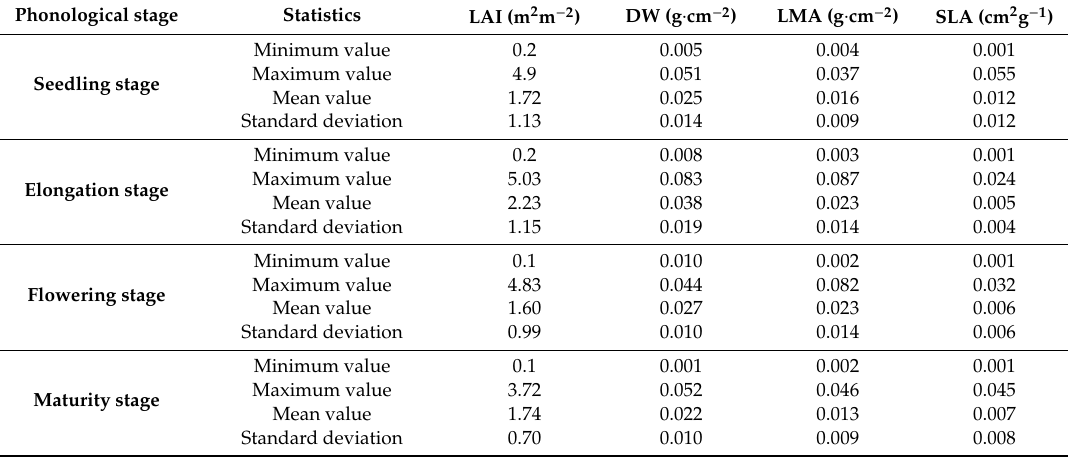
Table 2. Descriptive statistics of canopy LAI, DW, LMA and SLA of rapeseed oil at the di ff erent phenological stages in the Zishi experimental station.